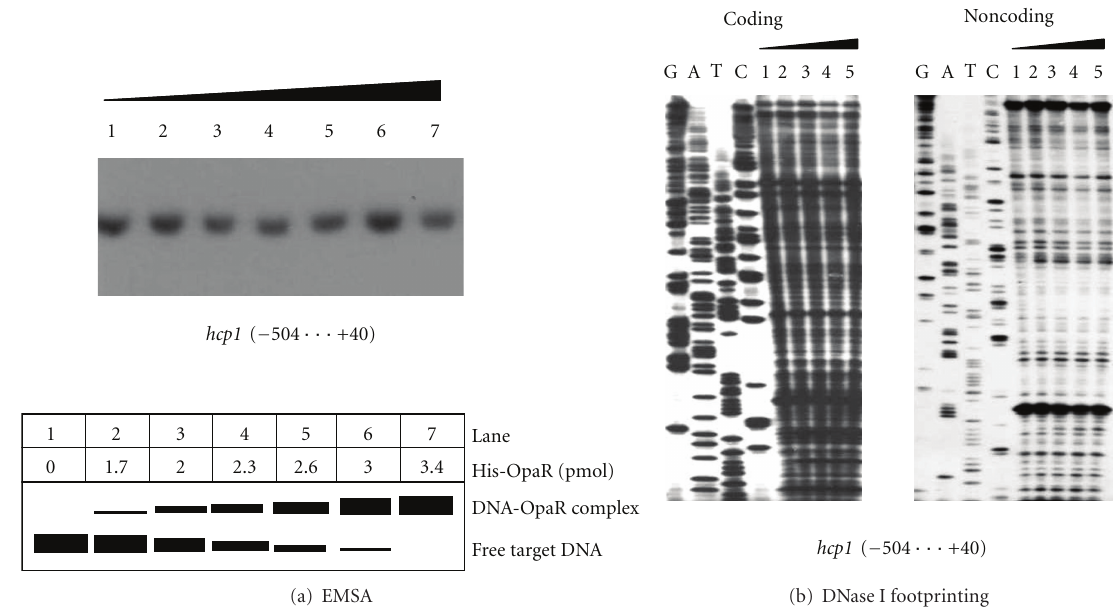
Figure 4: DNA binding analysis. (a) EMSA.The radioactively labeled DNA fragment from the 504bp upstream to the 40bp downstream of hcp1 was incubated with increasing amounts of purified His-OpaR protein (lanes 1, 2, 3, 4, 5, 6, and 7 containing 0, 1.7, 2.0, 2.3, 2.6, 3.0, and 3.4pmol, resp.) and then subjected to 4% (w/v) polyacrylamide gel electrophoresis. Shown also was the schematic representation of the EMSA design. (b) DNase I footprinting. Labeled coding or noncoding DNA probes were incubated with increasing amounts of purified His-OpaR (lanes 1, 2, 3, and 4 containing 0, 6, 12.5, 18.8, and 25pmol, resp.) and subjected to DNase I footprinting assay. Lanes G, A, T, and C represented the Sanger sequencing reactions. The footprint regions were indicated with vertical bars. The negative or positive numbers indicated the nucleotide positions upstream or downstream of hcp1 , respectively.